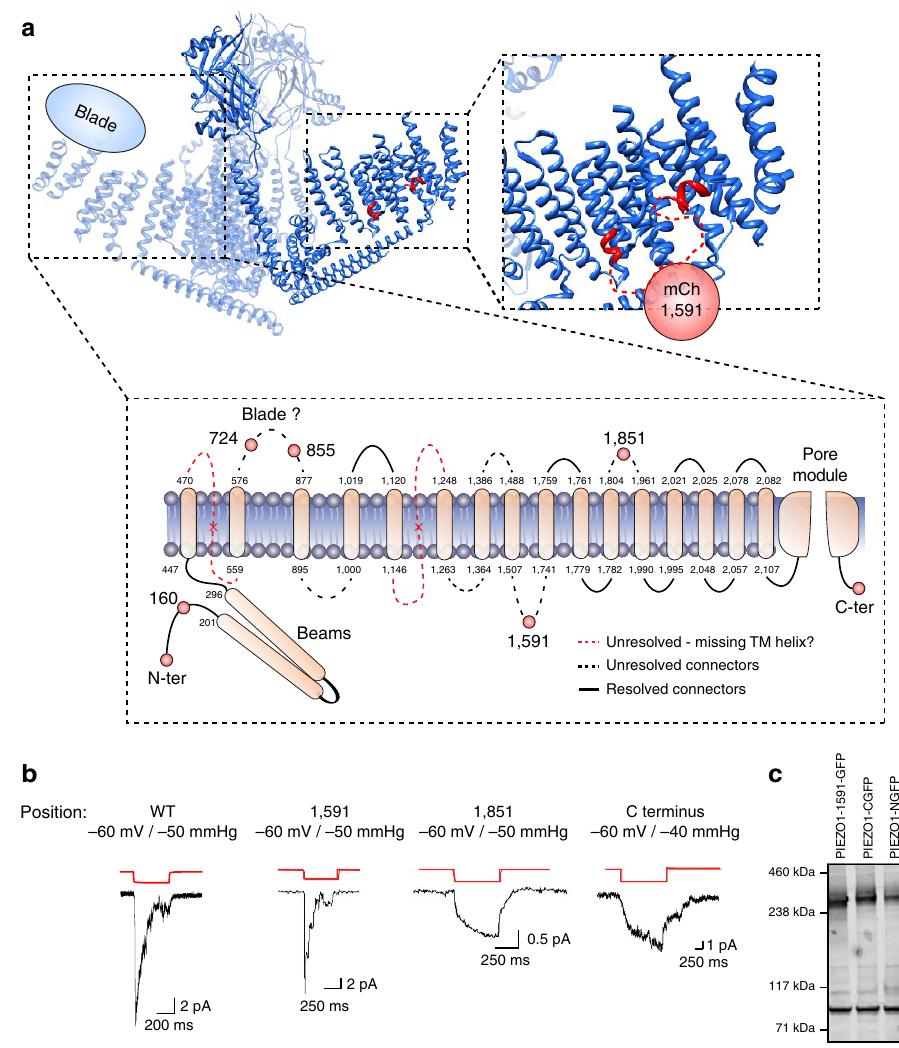
Figure 5 | Activity of different PIEZO1 fluorescent constructs using GFP and mCherry. ( a ) Cryo-EM structure of mouse PIEZO1 with an inset showing the likely position of the 1591 insertion (mCherry or GFP) 47 . In addition, we show the putative topology of the transmembrane segments and the positioning